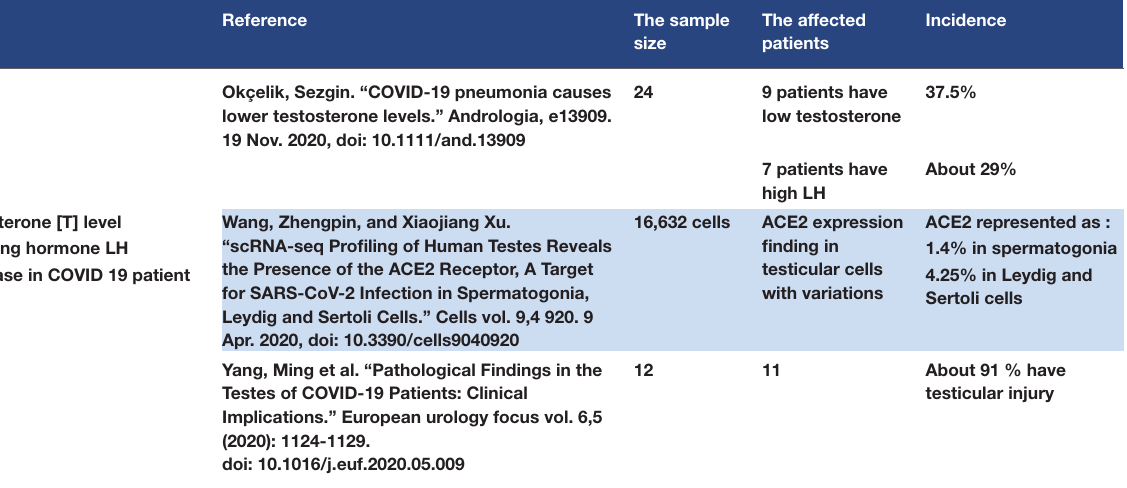
TABLE 10 | The defect in testosterone in COVID 19. The